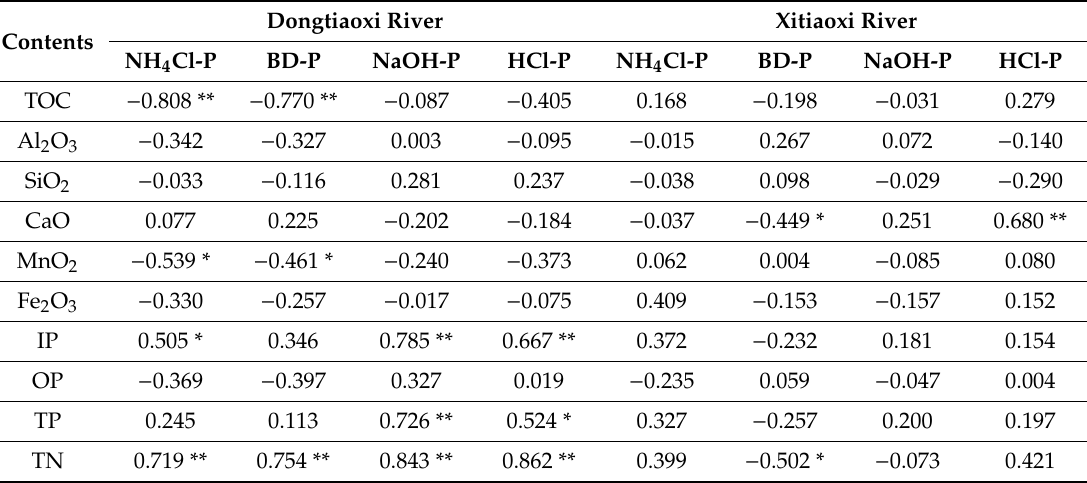
Table 4. Pearson’s correlation coe ffi cient of phosphorus fractions of sediments in Tiaoxi